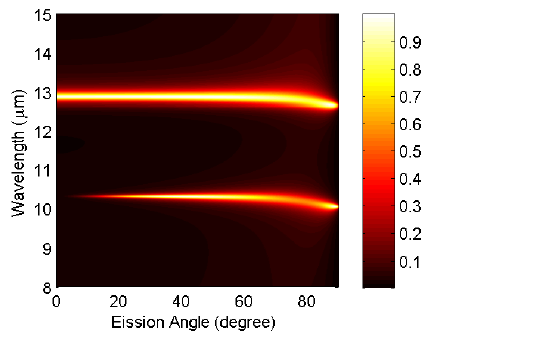
Figure 9: Emissivity of the SiC/Cu bilayer structure vs. emission angle and wavelength. The thickness of the SiC and Cu layer is, respectively, 320 nm and 150 nm. Color bar represents the magnitude of the emissivity. The shorter (longer) wavelength band is located at the left (right) side of Lorentzian resonance (see left panels in Fig. 8).